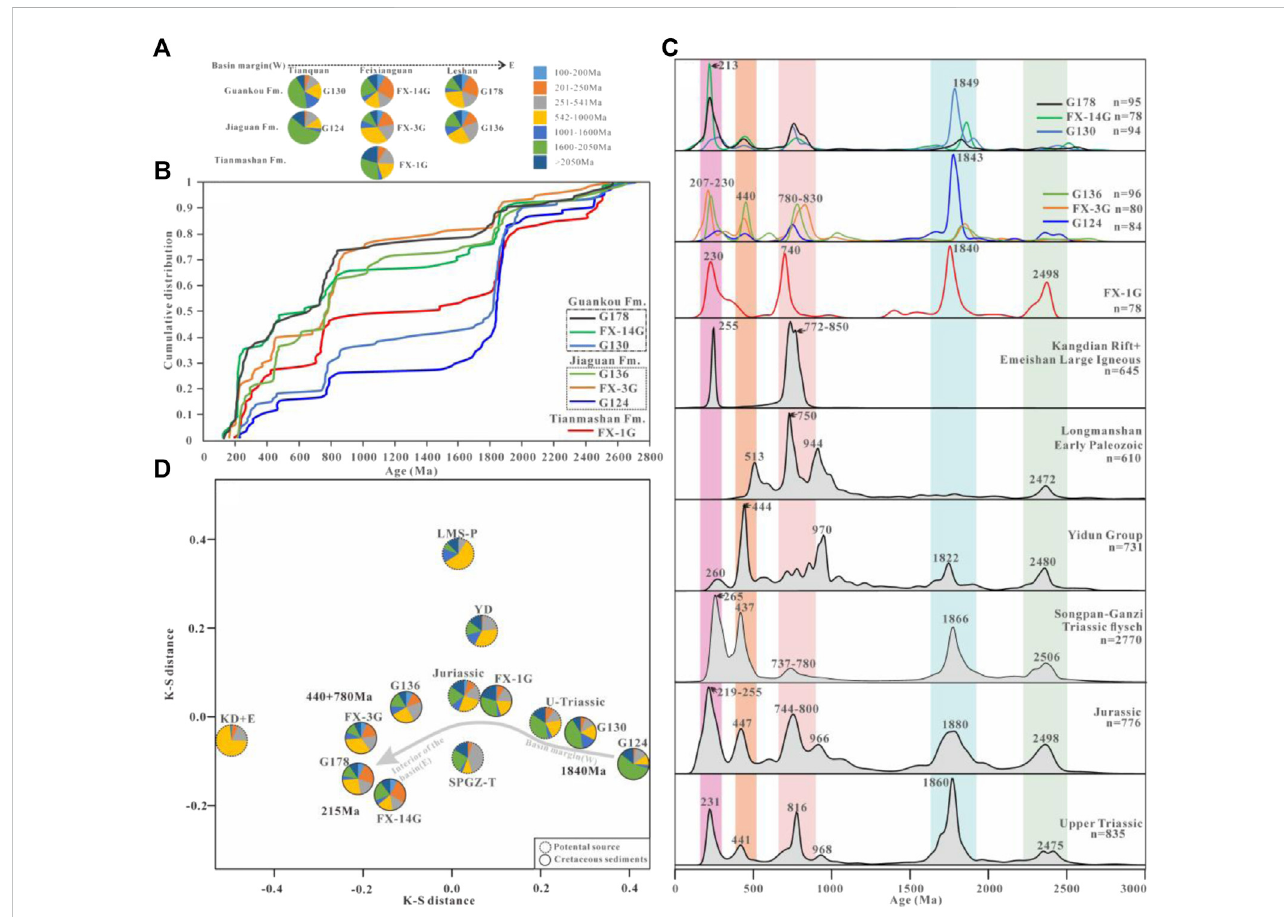
FIGURE 13 Detrital zircon U-Pb age result of the Cretaceous sediments in the Southwest corner of Sichuan Basin compared to age spectra from potential source regions. Data are shown as (A) pie diagrams, (B) cumulative distributions, (C) normalized probability density plots, and (D) a multi-dimensional scaling (MDS) plot. Data sources: Triassic fl ysh sediments in the Songpan-Ganzi fold belt (SPGZ-T) (Weislogel et al., 2006, 2010; Enkelmann et al., 2007; Tang et al., 2017; Jianetal.,2019);YidunGroupintheYiduanterrane(YD)(WangB.Q.etal.,2013);Kangdianrift(lateNeoproterozoiccomplexes:LiX.H.etal.,2002;LiZ.X. et al., 2002, Li Z. X. et al., 2003; Zhou et al., 2006a; Zhao and Zhou, 2007; Huang et al., 2009; Zhao X. F. et al., 2008; Zhao J. H. et al., 2008; Sun et al., 2009; Wang L. J. et al., 2012) and Emeishan Large Igneous Province (Shellnutt, 2014 and references therein) (KD+E); Early Paleozoic sediments from the Longmenshan orogenic belt (LMS-P): Duan et al., 2011; Chen et al., 2016, 2018; Upper Triassic sediments in southwestern and western Sichuan Basin: Deng et al. (2008), Chen et al. (2011), and Zhang et al. (2015); Jurassic sediments in the southwestern and western Sichuan Basin: Shao et al. (2016); Li et al. (2018). Cretaceous sediments (Li et al., 2018): Jiaguan Formation (G124) and Guankou Formation (G130) from Tianquan; Jiaguan Formation (G136) and Guankou Formation (G178) Formation from Leshan. The sample position is shown in Figure